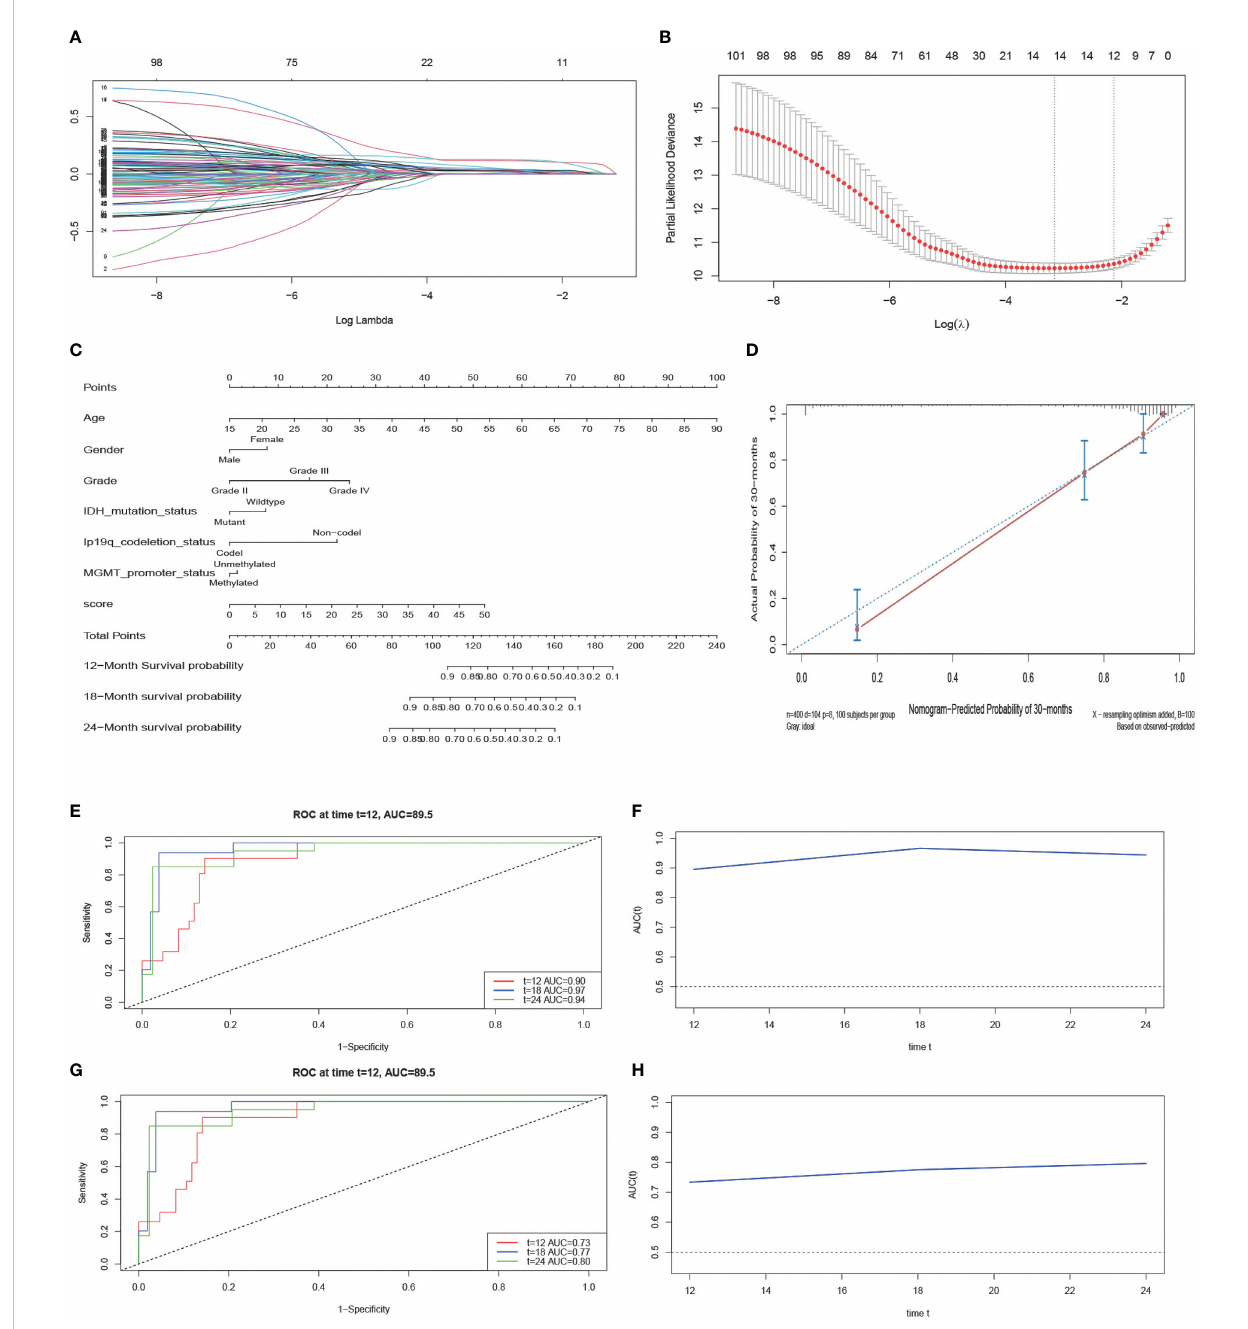
FIGURE 4 LASSO regression analysis and construction and calibration of the nomogram. (A, B) Twelve candidate genes screened out by LASSO with the minimum cross-validation error. (C) Nomogram integrating risk score and clinical characteristics. (D) Calibration of the nomogram at 30-month survival in the training cohort. (E, F) The AUC of time-dependent ROC at 12-month, 18-month, and 24-month survival in the test cohort. (G, H) The AUC of time-dependent ROC at 12-month, 18-month, and 24-month survival in the external